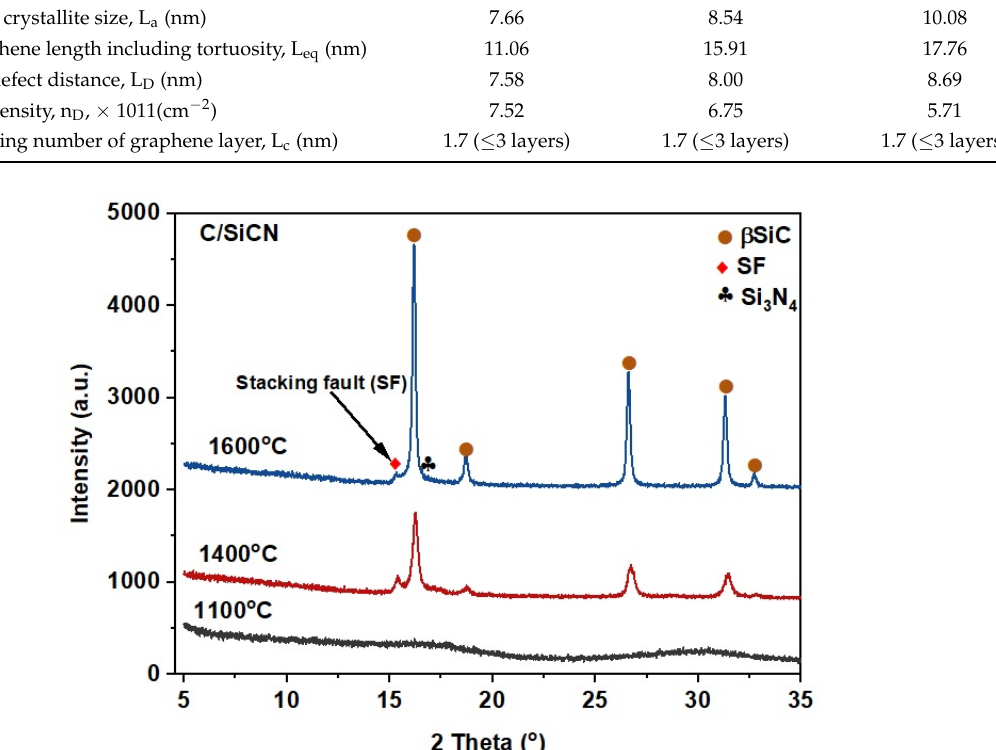
Figure 3. An XRD pattern of the C/SiCN monoliths fabricated at different temperatures.